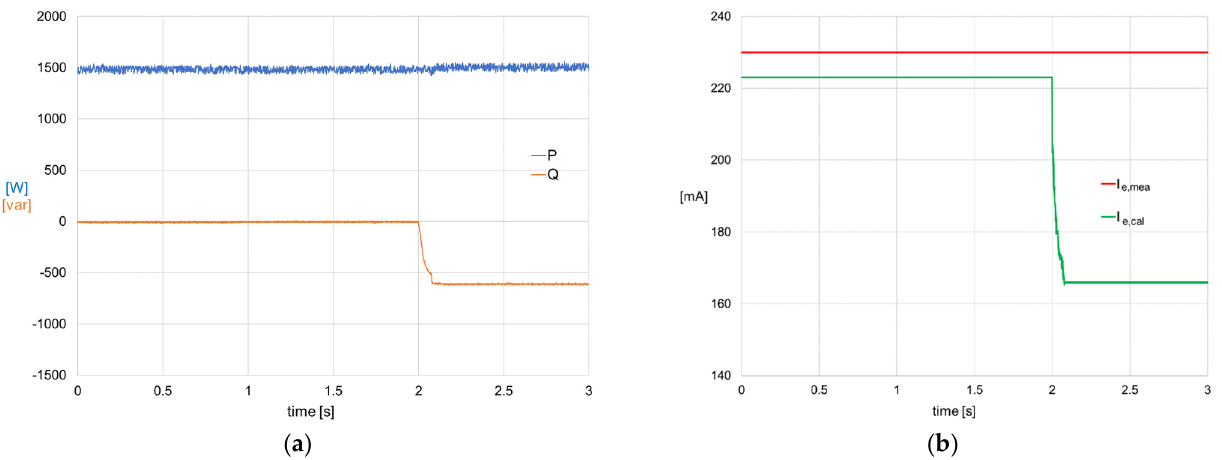
Figure 20. Healthy-to-faulty transition for a sudden open-phase fault (F3), with fixed P = 1500 W